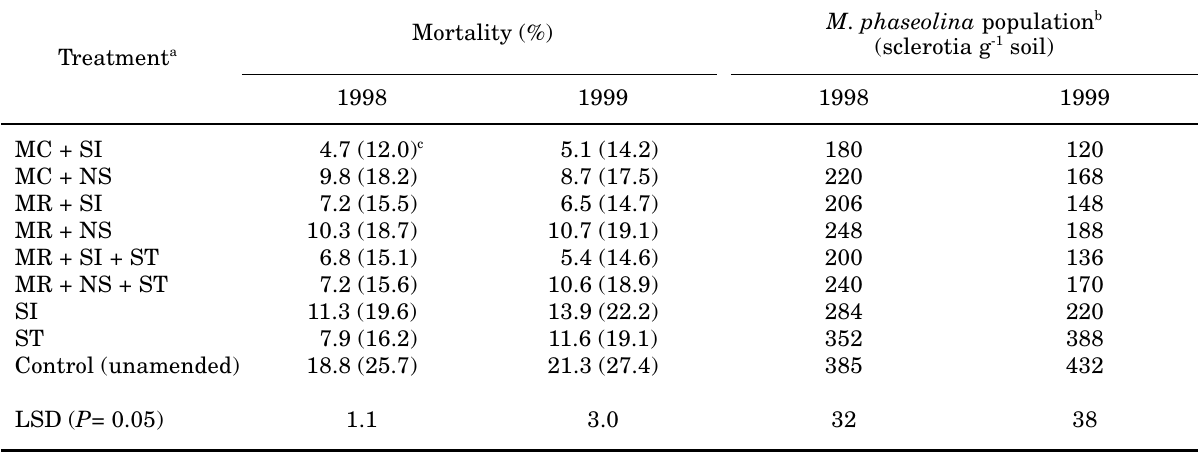
Table 3. Effect of cruciferous residues as a soil amendment on Macrophomina phaseolina and clusterbean mortality due to dry root rot on